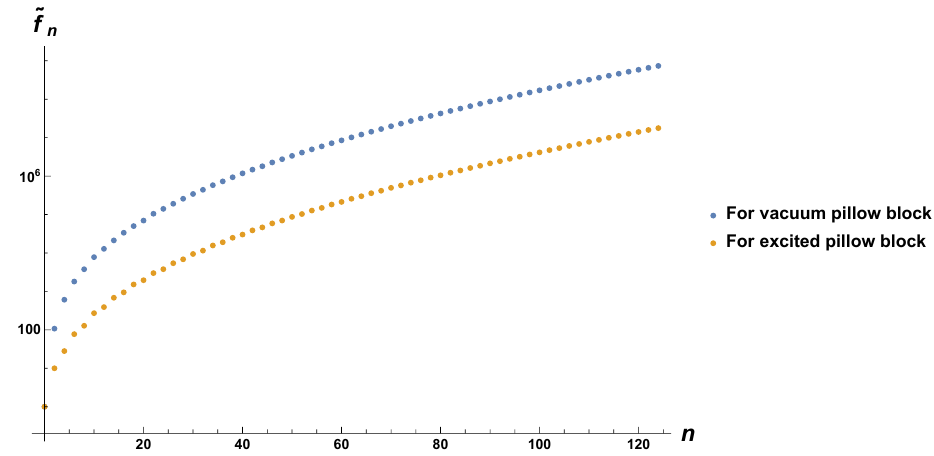
Figure 4 . Even q -expansion coefficients in pillow blocks for the example (4.25) are plotted. Odd ones vanish. y -axis is